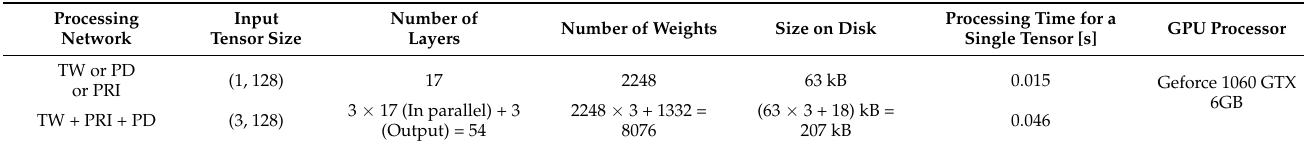
Table 6. The designed network